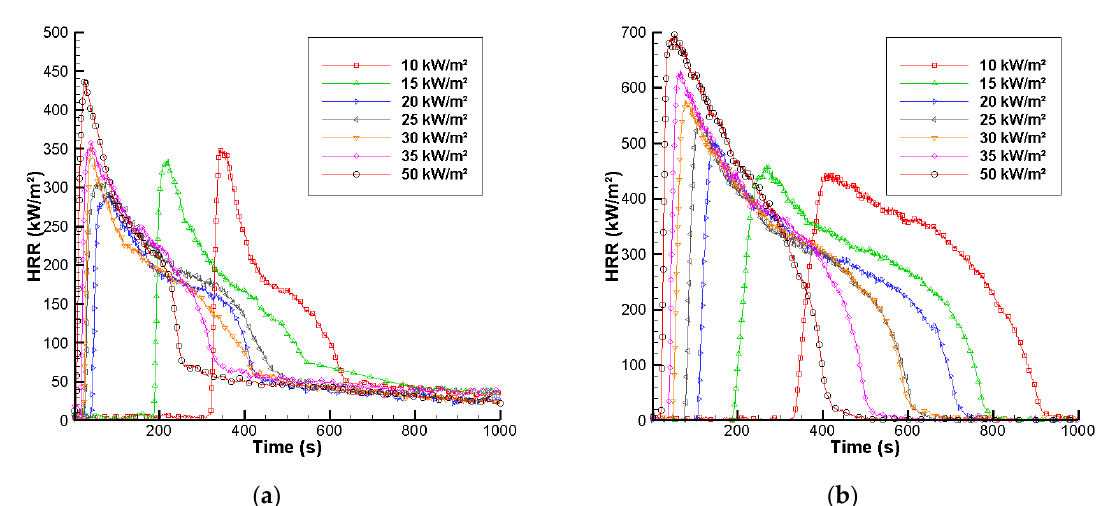
Figure 5. Heat Release Rate (HRR) as a function of time for imposed heat fluxes ranging from 10 to 50 kW/m 2 for ( a ) wood and ( b ) thermoplastic samples. Table 3. HRR peak, t ign and t fl am phase for wood and thermoplastic samples for di ff erent heat fl uxes.